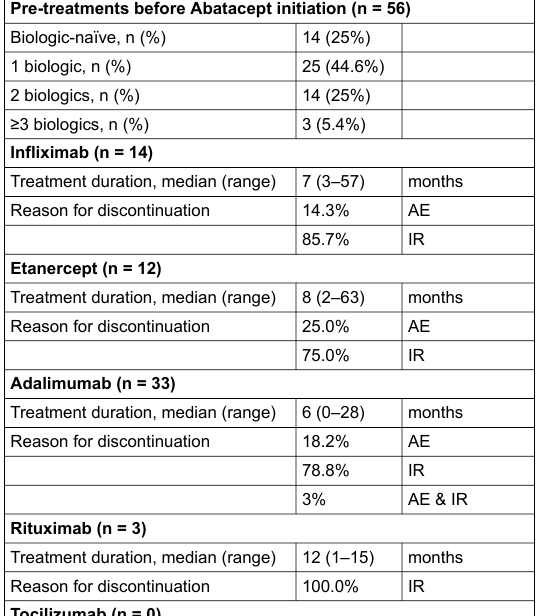
Table 2: Pre-treatments and reasons for switching to abatacept (AE: adverse event; IR: inadequate response). Pre-treatments before Abatacept initiation (n = 56)